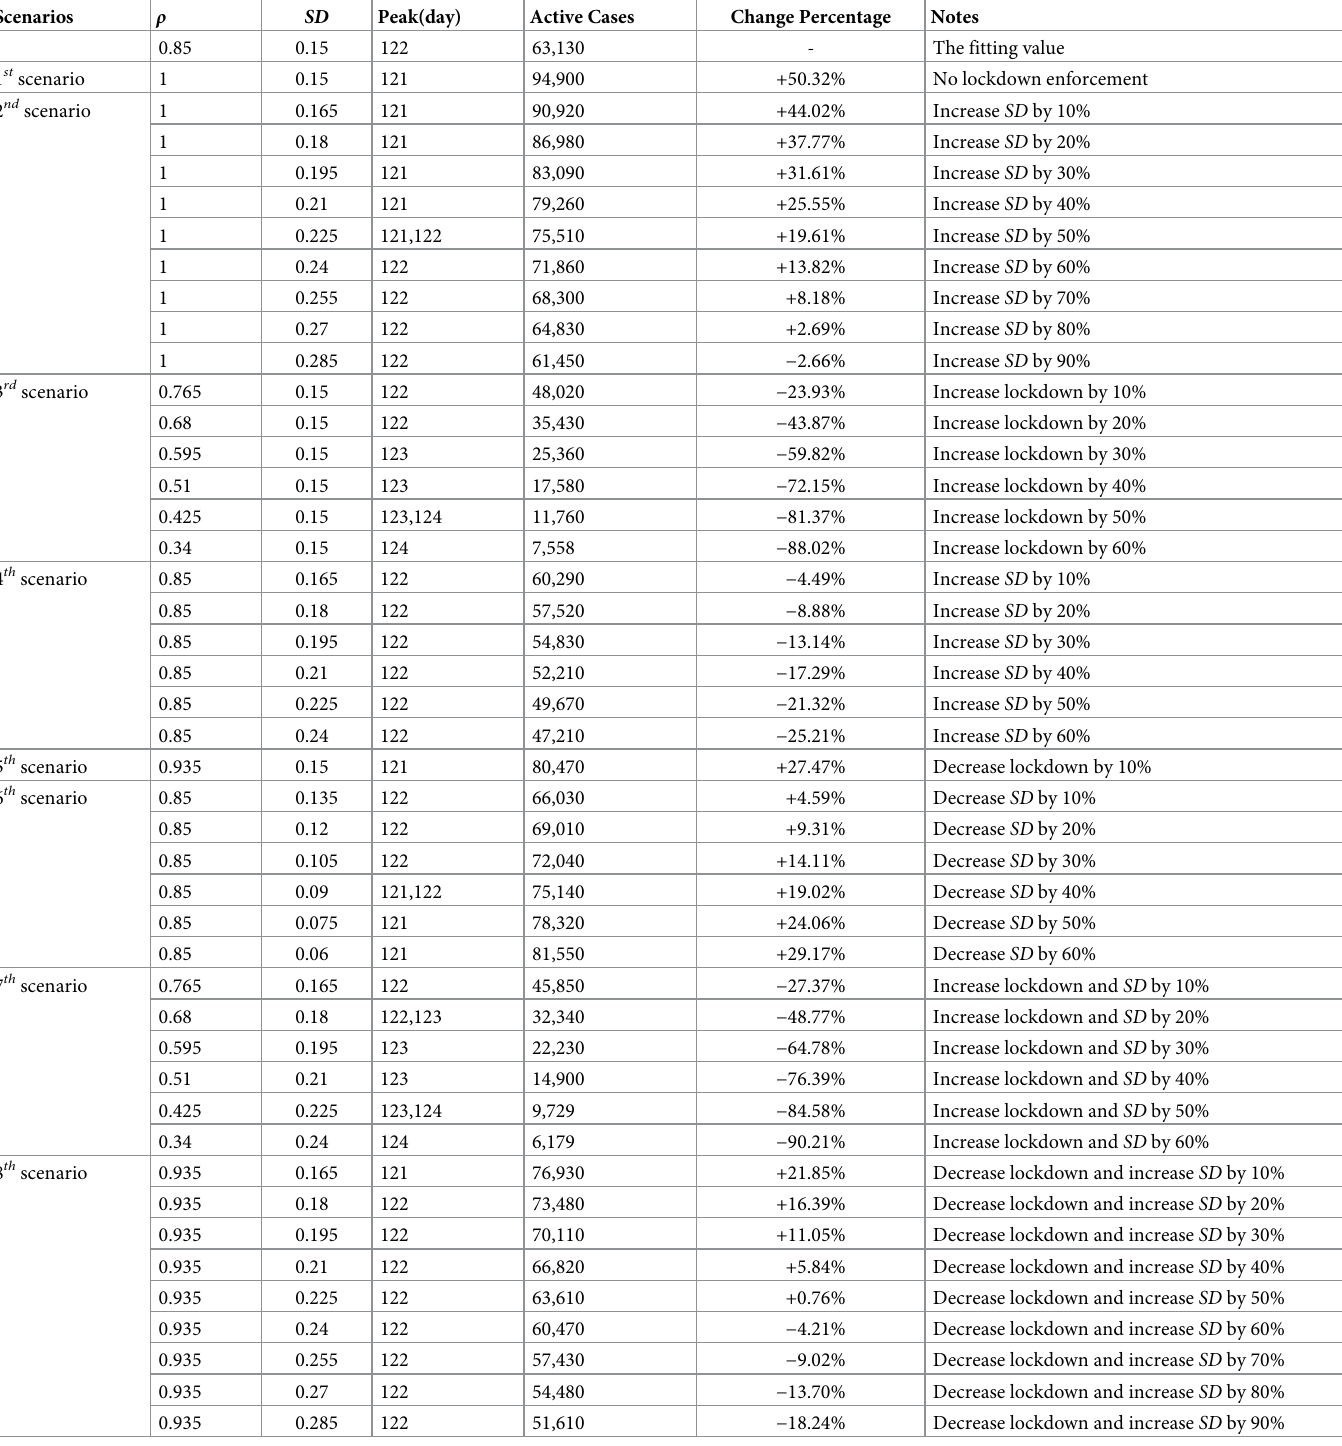
Table 4. Results of different scenarios for Phase